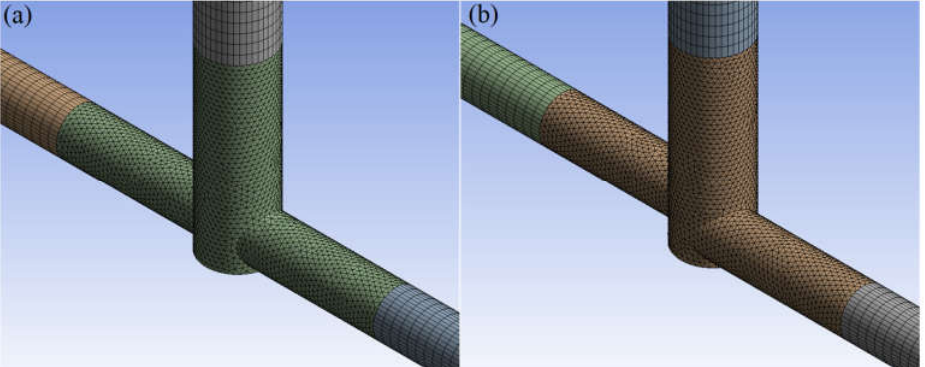
Figure 2. Mesh of ( a ) T-type and ( b ) S-type reactors .